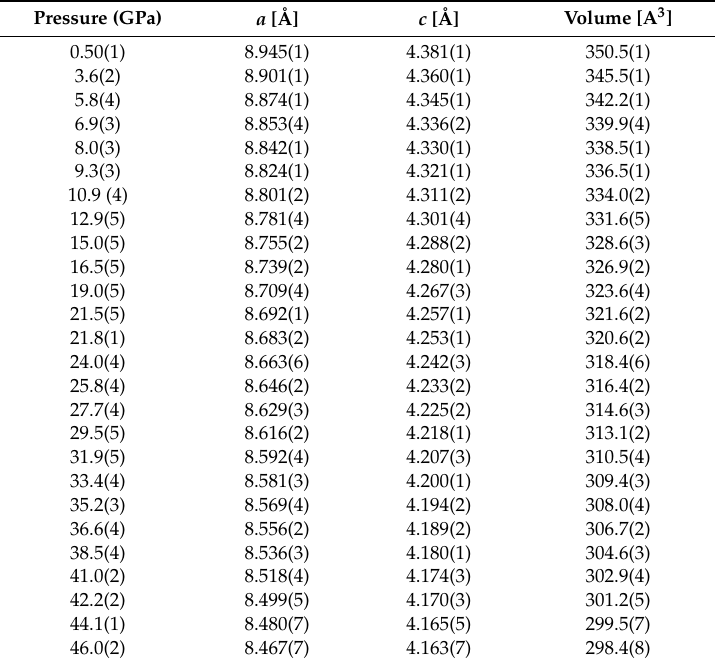
Table 3. Pressure dependence of the unit cell parameters of Ni 3 P determined in the powder di ff raction